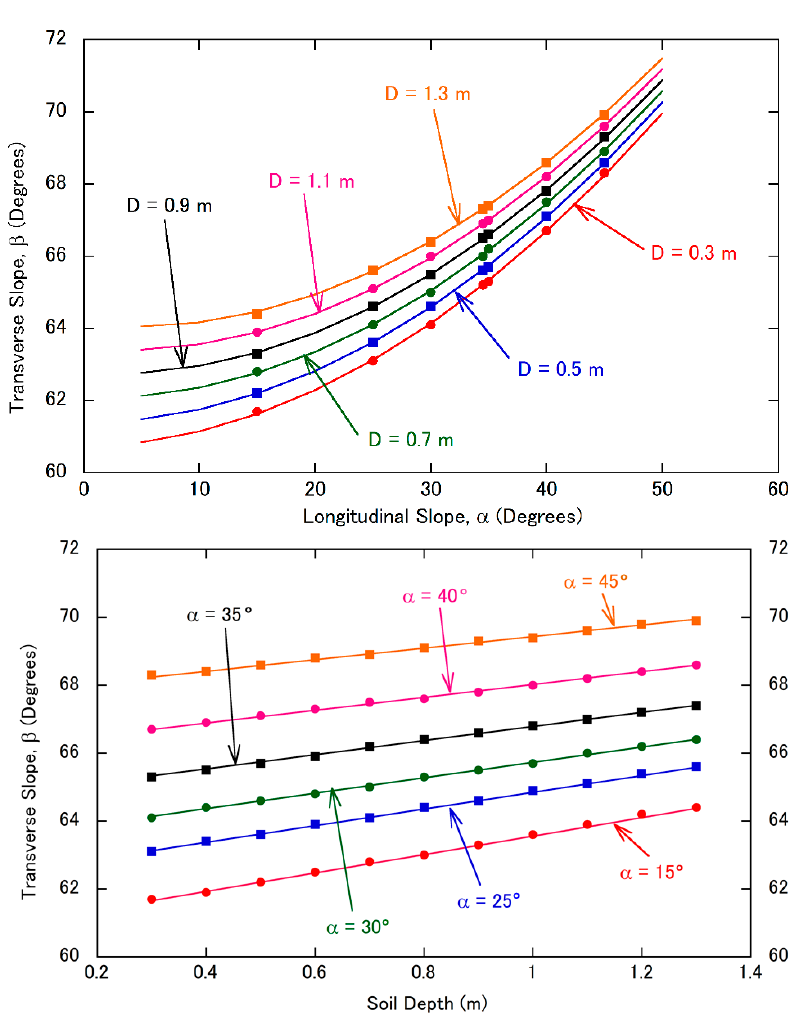
Figure 7. Changes in the transverse slope ( β ) according to ( a ) the longitudinal slope ( α ) and ( b ) soil depth ( D ).